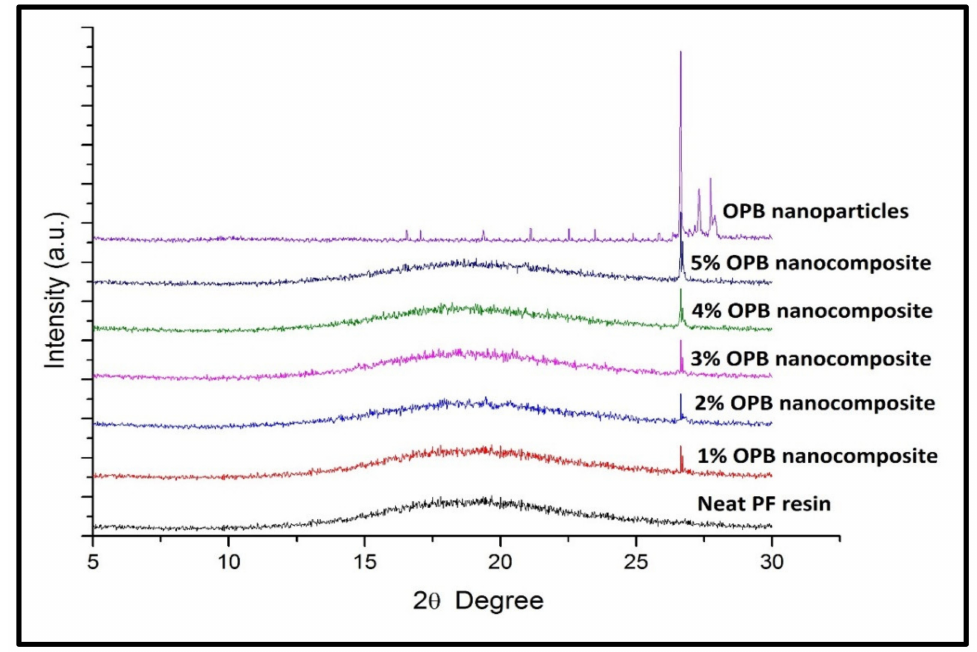
Figure 7. XRD spectroscopy of neat PF resin and PF nanocomposite-filled OPA nanoparticles. The broadening (width) of the XRD spectrum indicated the effect of lattice